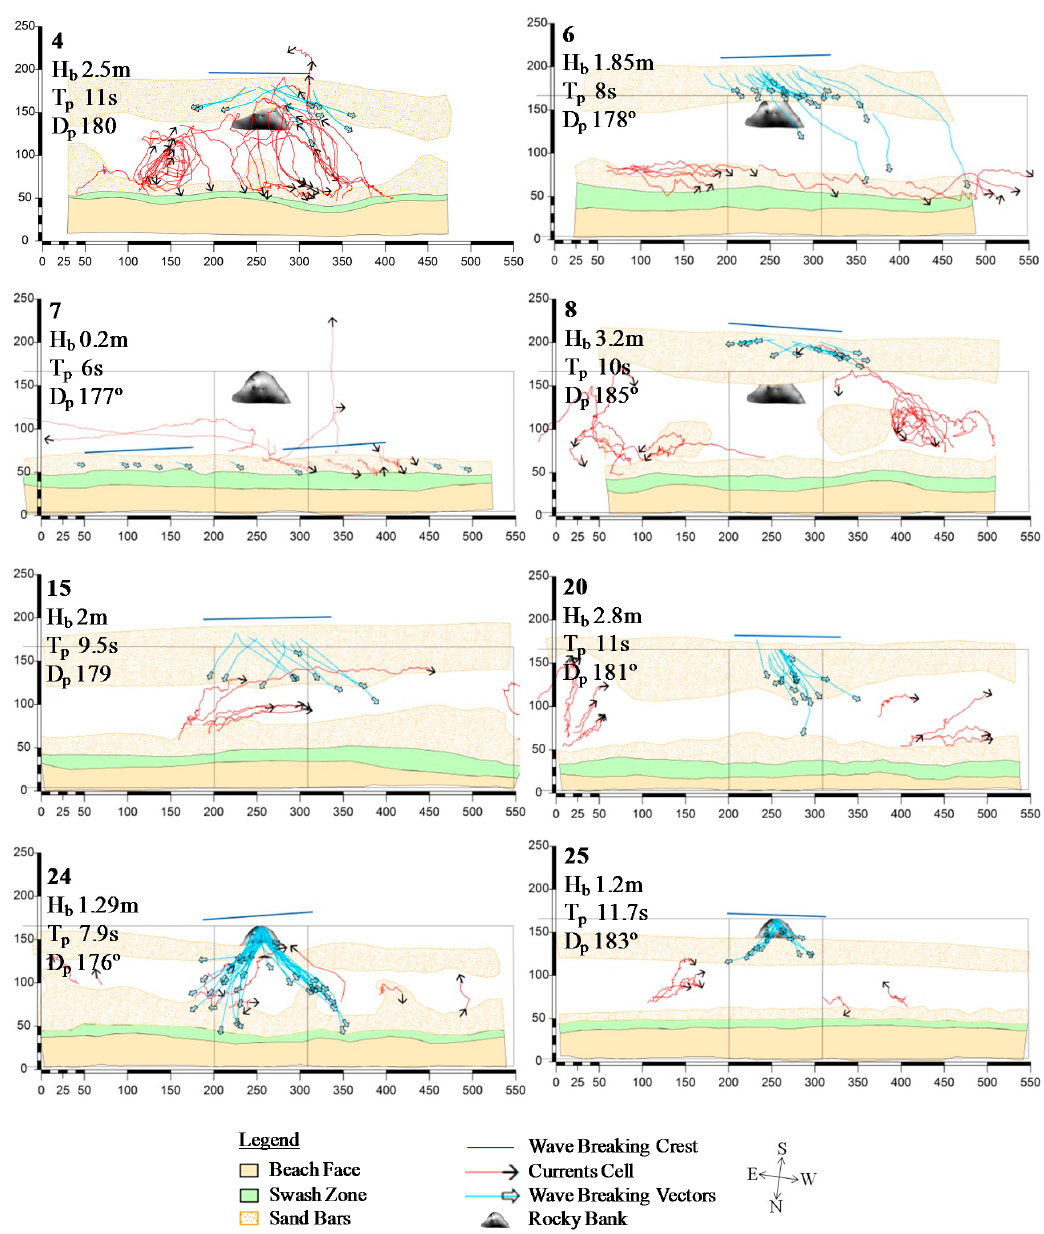
Figure 7. Bidimensional response of the morphological (beach face, swash zone, and sand bars) and hydrodynamic (currents cell tracked and wave breaking vector tracked) features of the Reserva Beach system. The configuration of these eight cases were grouped, taking into account the dissipative morphological feature at the beach. The onshore sand bars depth is − 1.5 m, and the offshore sand bars depth is − 2 m, relative to the mean sea level for each day. The wave data parameters (H b , T p and D p ) during each case are also